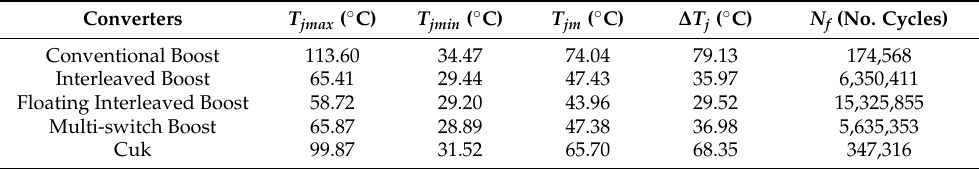
Table 1. The obtained results from the power cycling test for all five converters. Converters T jmax ( ◦ C) Conventional